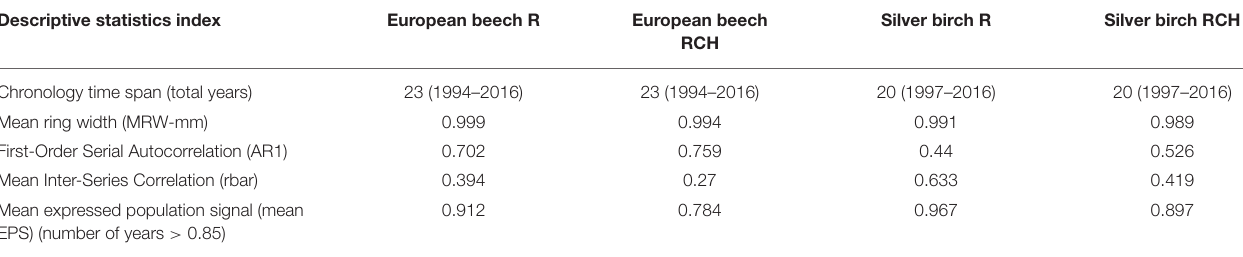
TABLE 6 | Descriptive statistical parameters of ring width, elaborated by R software.